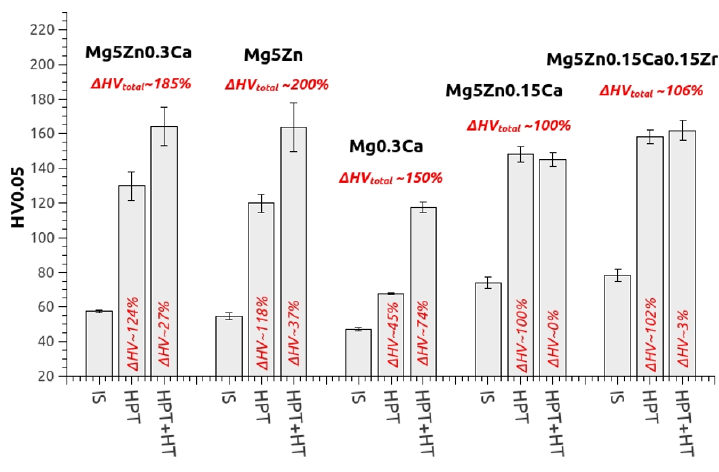
Figure 12. Total hardness increases of Mg5Zn0.3Ca, Mg5Zn, Mg0.3Ca, Mg5Zn0.15Ca and Mg5Zn0.15Ca0.15Zr from the IS (furnace ‐ cooled), HPT processing at 4 GPa and 0.5 rotations; and additionally, heat treatment at the peak temperatures of 100 °C for 24 h, and 75 °C for 24 h for